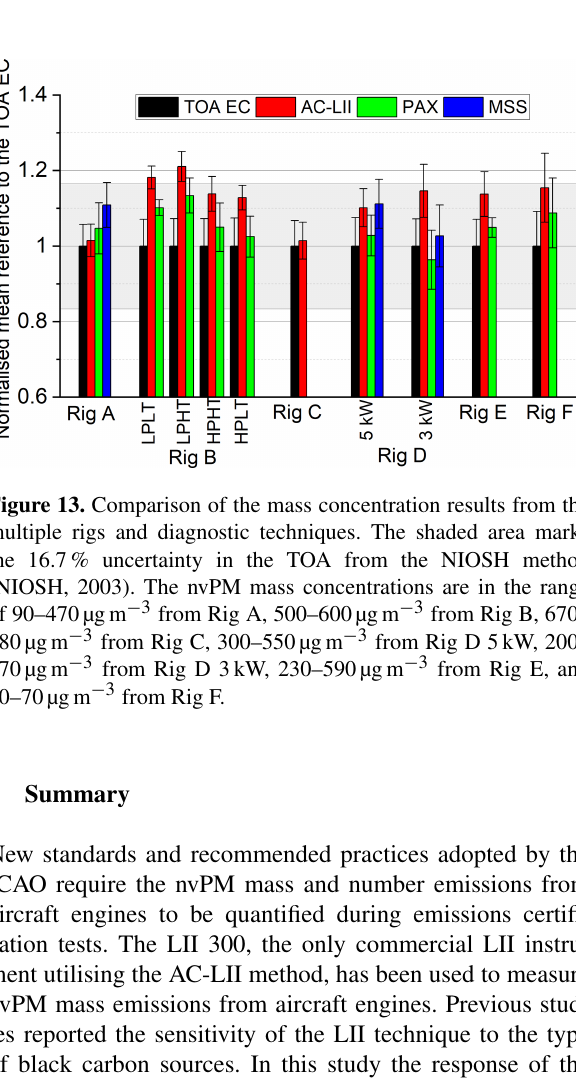
Figure 12. (a) Mass concentration profiles for LII 300, PAX, and MSS and (b) correlations between LII 300 and MSS nvPM mass concen- trations to those from PAX (Rig A).